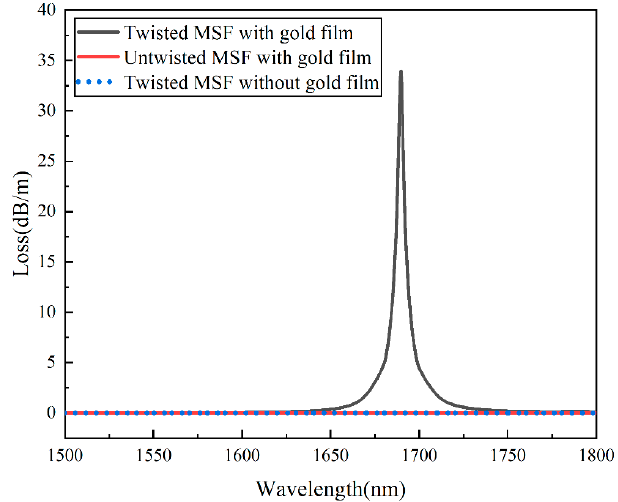
Figure 3. Comparison of the losses of HMSF with gold film, untwisted MSF with gold film, and HMSF without gold film.